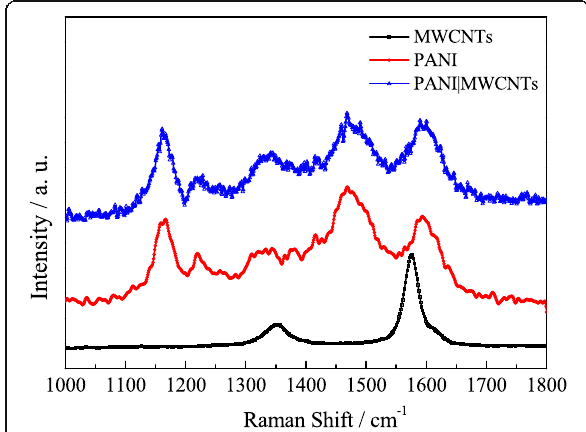
Fig. 5 Raman spectrum of MWCNTs, PANI, and